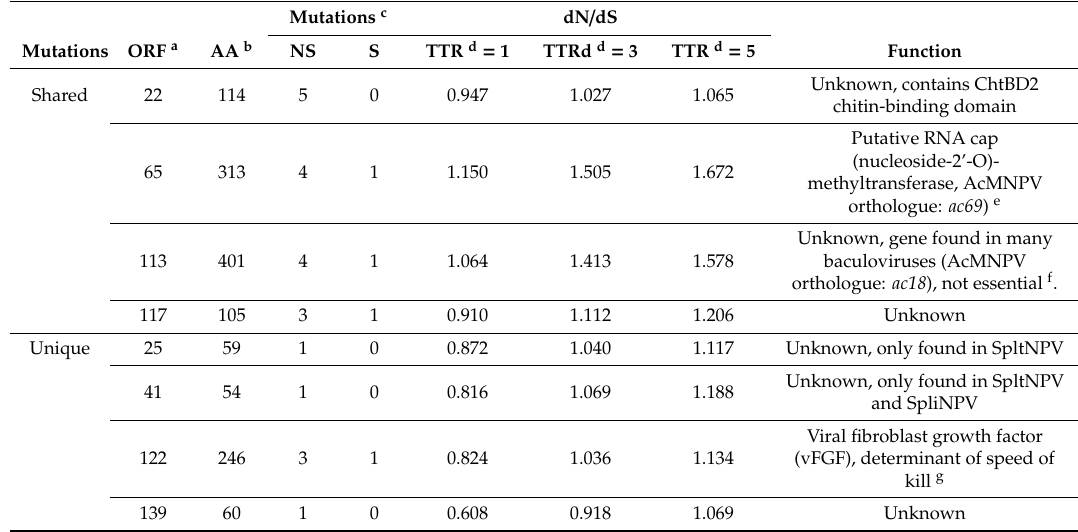
Table 3. Genes under neutral or purifying selection for the dN / dS